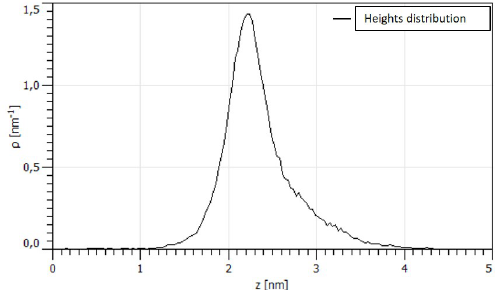
Figure 5. Distribution of asperity